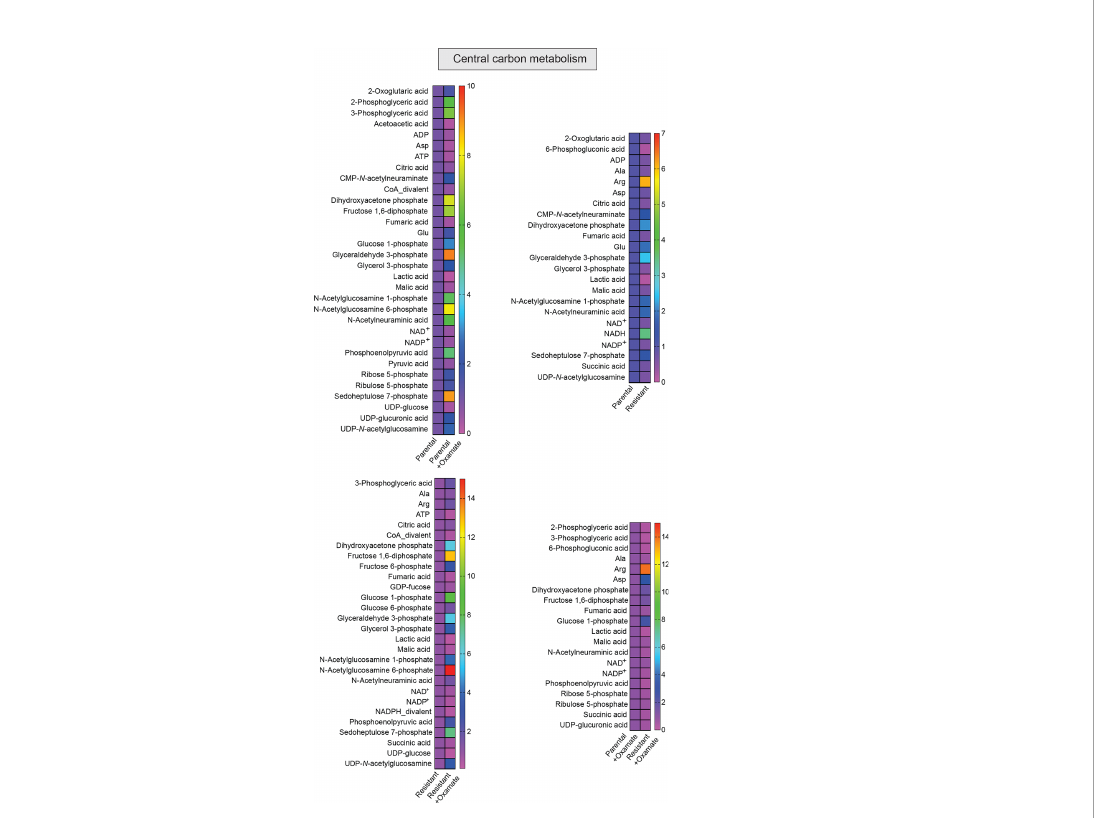
FIGURE 5 Metabolites generated during central carbon metabolism in parental and oxamate-resistant cells treated with or without sodium oxamate. Changes in the indicated metabolites generated during central carbon metabolism under the indicated